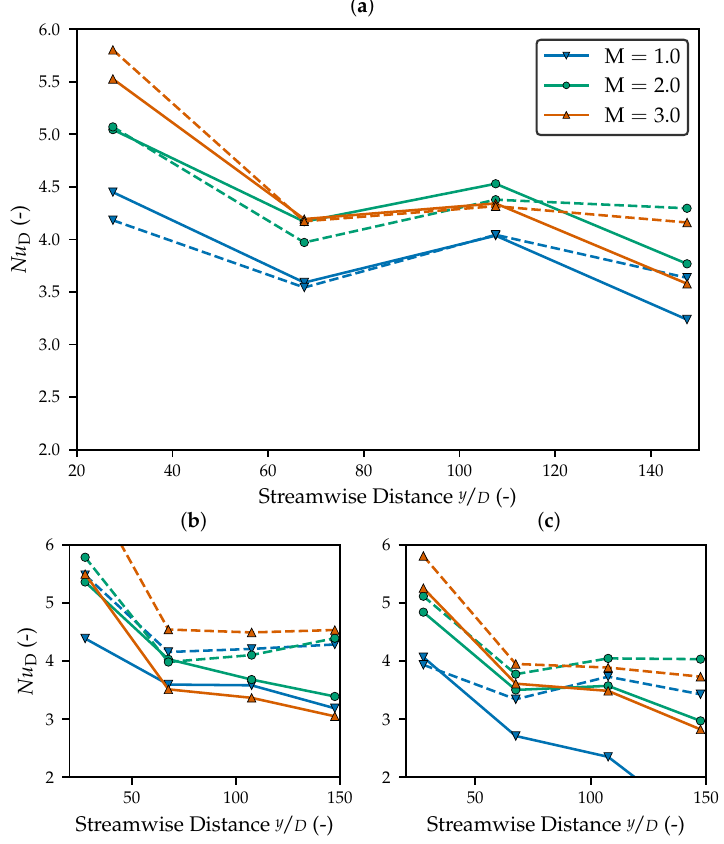
Figure 7. Nusselt numbers over streamwise length on the hot gas side of the effusion specimen averaged over area. ( a ) Nominal cavity height 5 D at top, ( b ) small cavity height 3 D bottom left, ( c ) large cavity height 7 D bottom right. Solid lines show aligned setup MALO00 ; dashed lines show misaligned setup MALO05